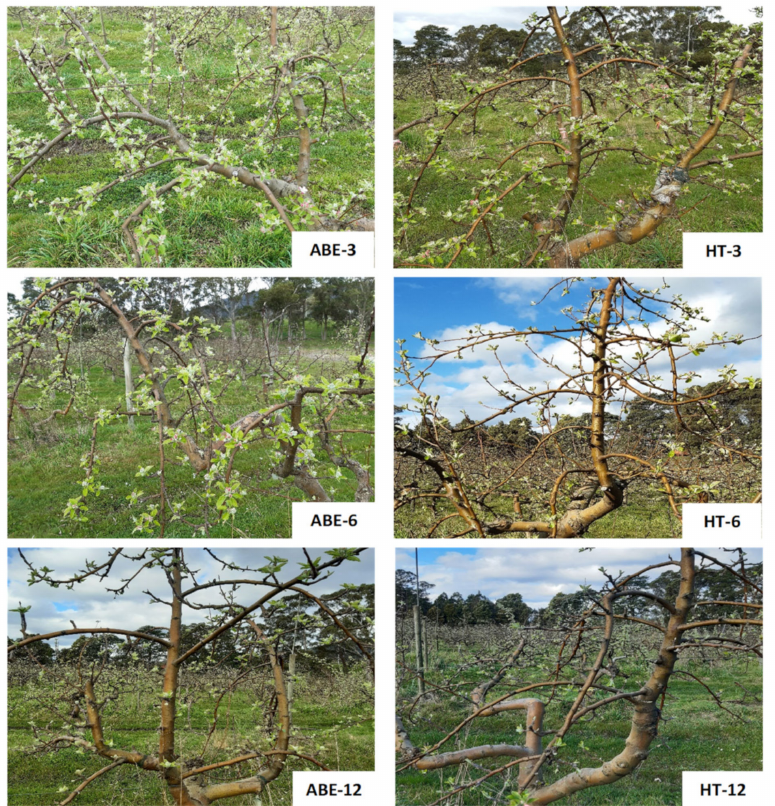
Figure 2. Photos illustrating the effect of thinning method and crop load on return bloom in season two.